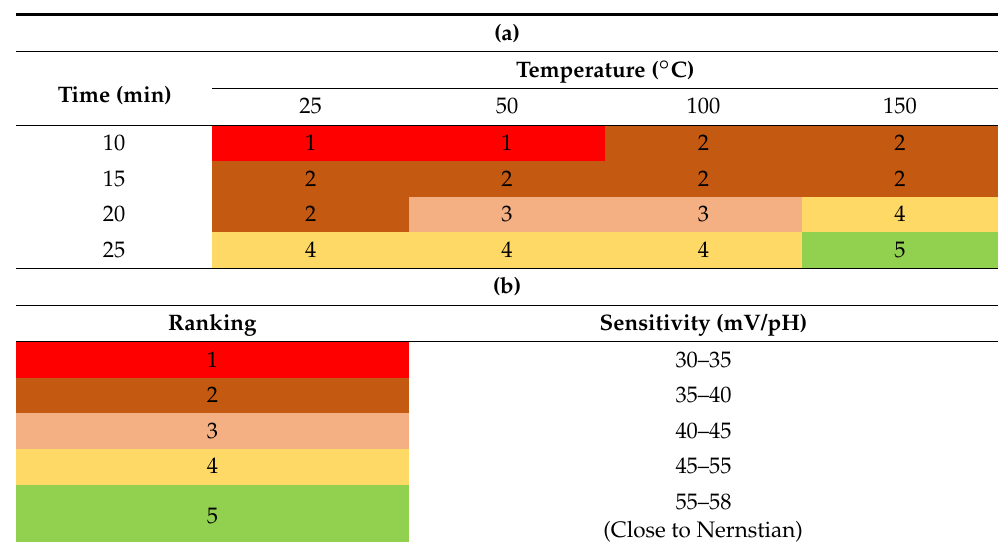
Table 1. ( a ) Nafion annealing time and temperature optimization based on pH sensitivity ranking. ( b ) pH Sensitivity ranking criteria.